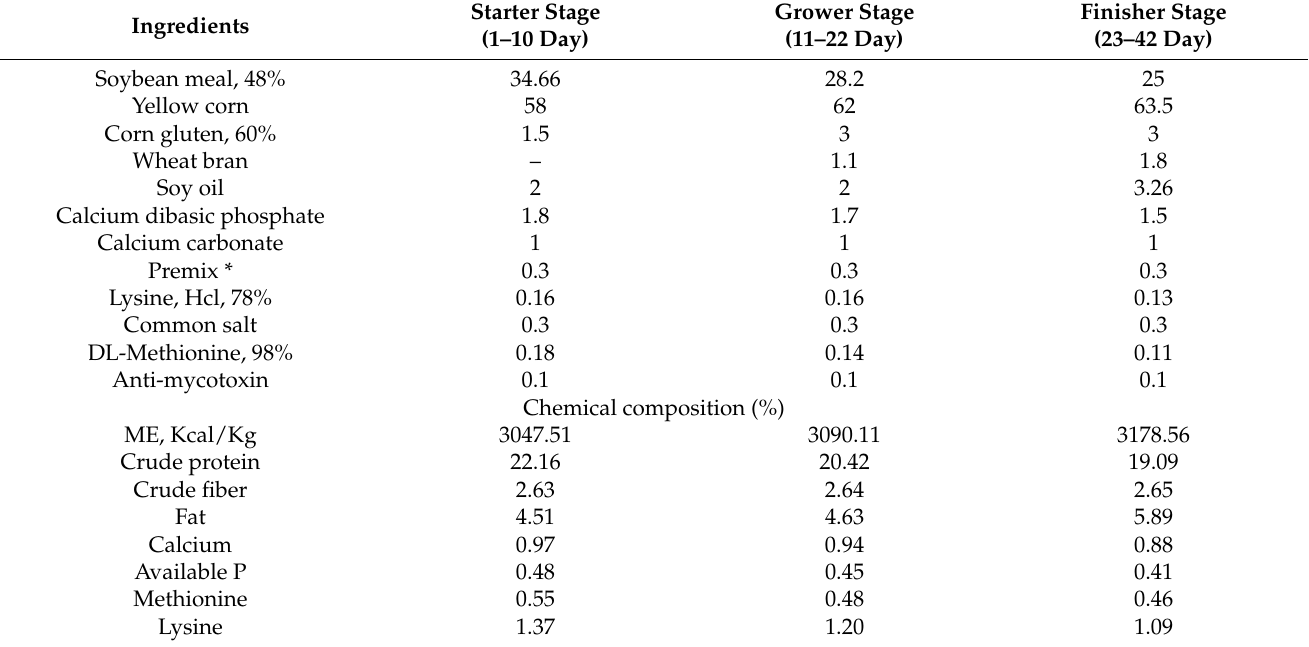
Table 1. Proximate and chemical composition of the basal diets